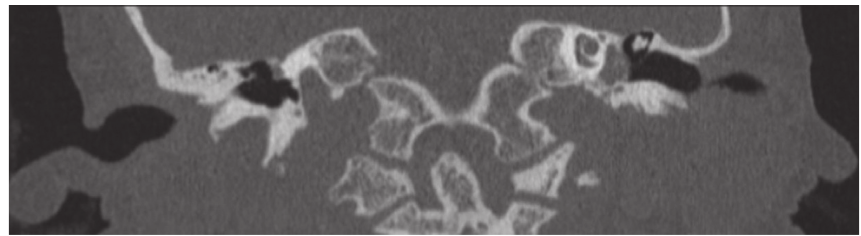
Figure 3: CT coronal view. Left mesotympanic and hypotympanic mass extending into the infracochlear space. Visible sharp.